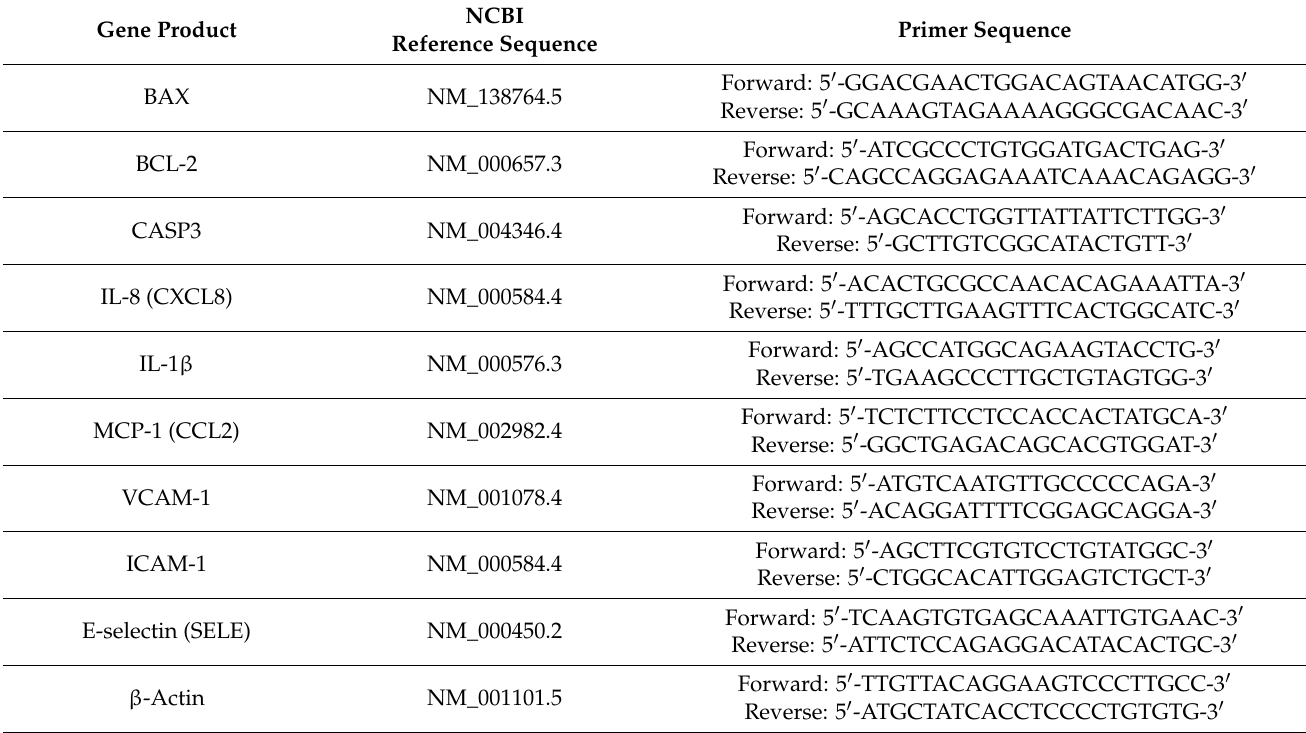
Table 1. Oligonucleotide primers of genes used for real-time